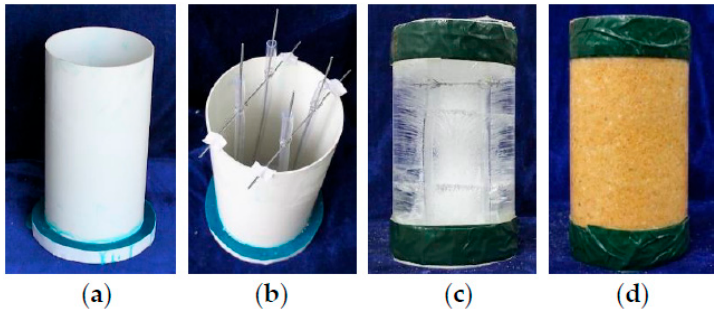
Figure 1. Preparation of plain ice and sawdust-reinforced ice specimens: ( a ) PVC formwork; ( b ) placement of hoses; ( c ) plain ice specimen; and ( d ) sawdust-reinforced ice specimen.